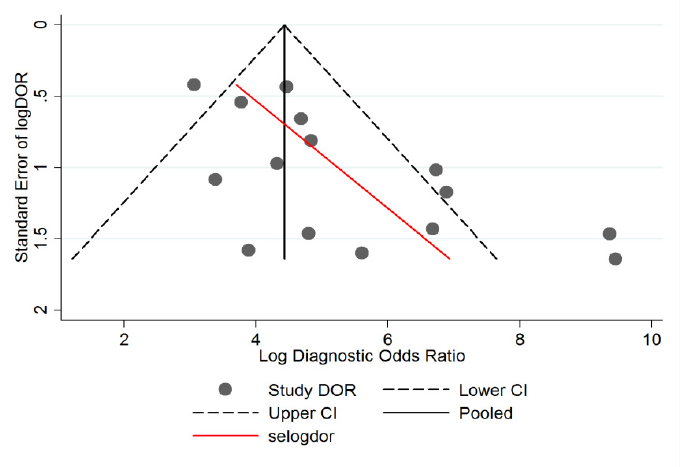
Figure 6. Plot with pseudo 95% confidence limits in the included studies.